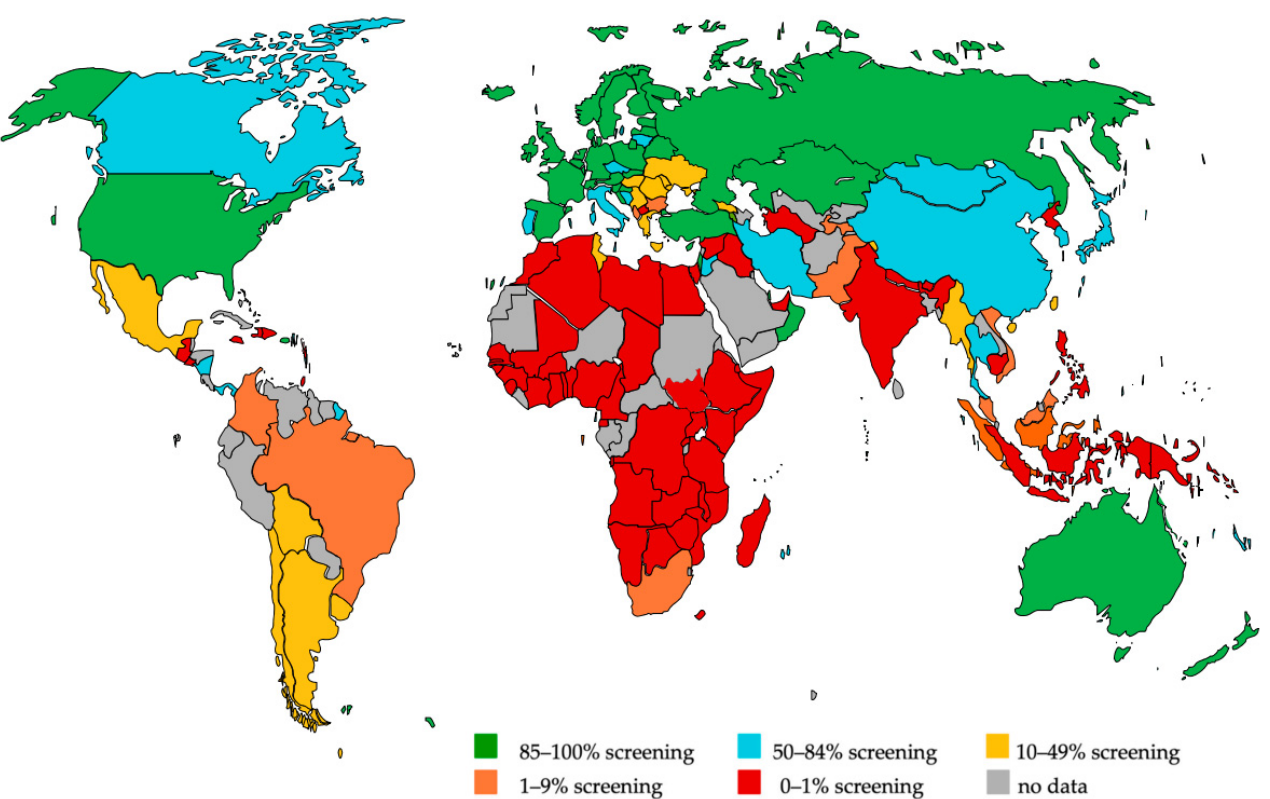
Figure 1. Country-specific coverage of newborn and infant hearing screening programs (modified from [33] with permission).